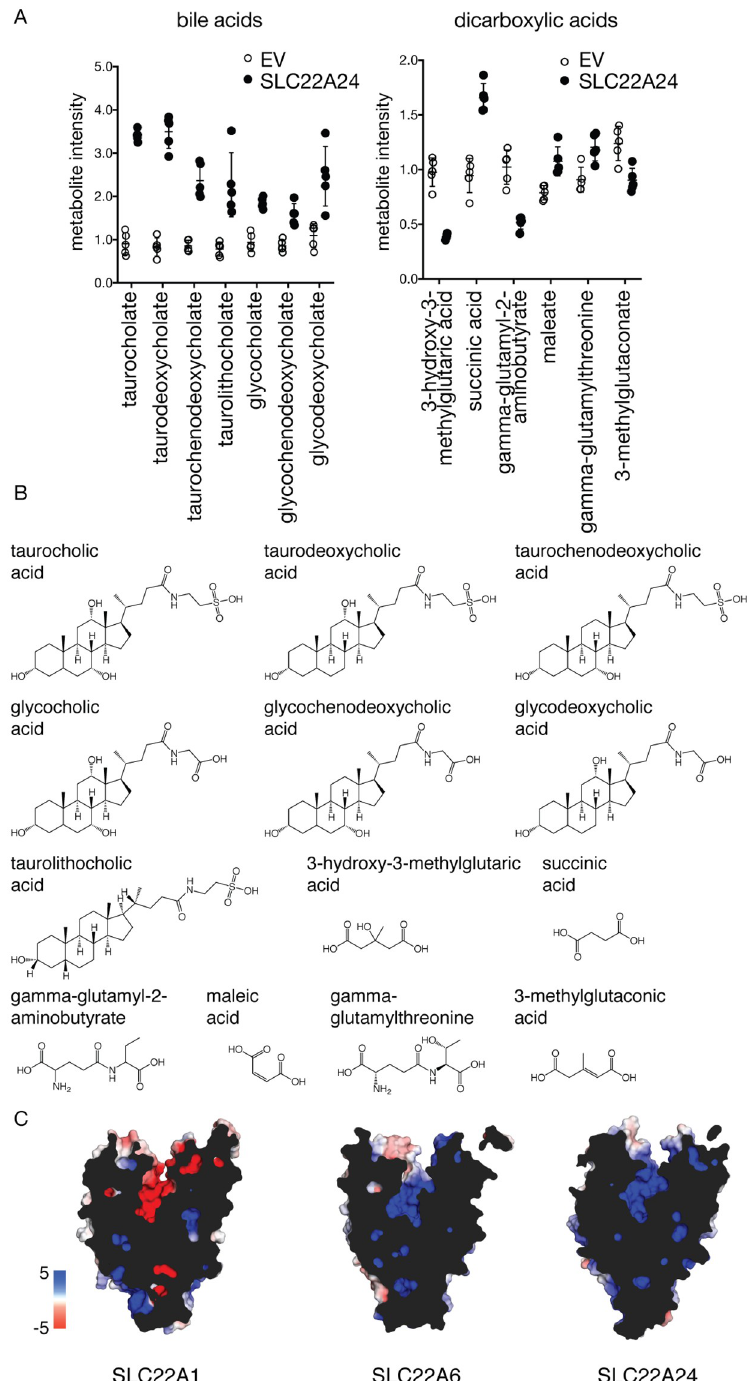
Fig 2. Metabolomic study and comparative structure models support the role of SLC22A24 as an anion transporter. (A) Cellular metabolite levels are significantly different between HEK293 Flp-In cells transiently transfected with empty vector (EV) or SLC22A24 for seven bile acids and six dicarboxylic acids among the top 50 metabolites. Underlying data are provided in S1 Data. (B) Chemical structures of the seven bile acids and six dicarboxylic acids. (C) Surface representations of the calculated electrostatic potential (-5 to 5 kT e -1 ) of the human SLC22A1, a characterized cationic transporter, the human SLC22A6, a characterized anionic transporter, and the human SLC22A24. The cross-section allows for visual inspection of the predicted binding